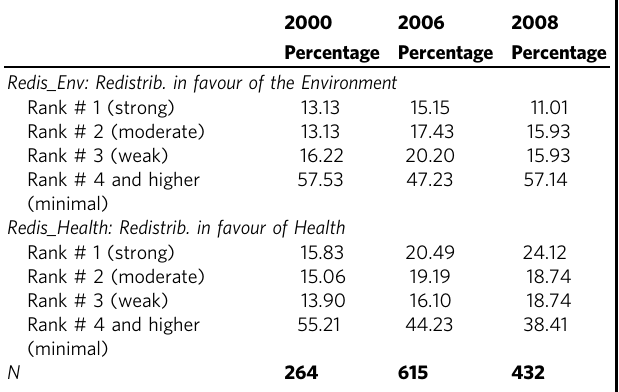
Table 2 Descriptive statistics for dependent variables.